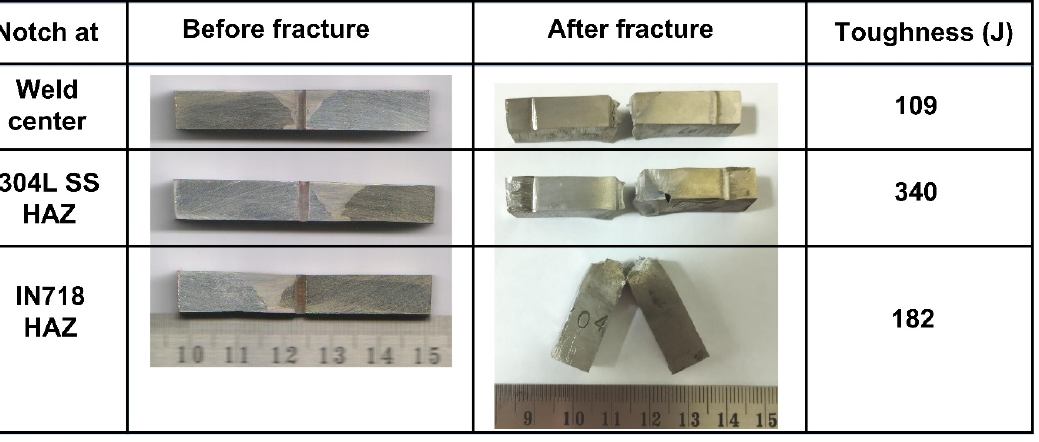
Figure 12. Hardness distribution across dissimilar weldment.